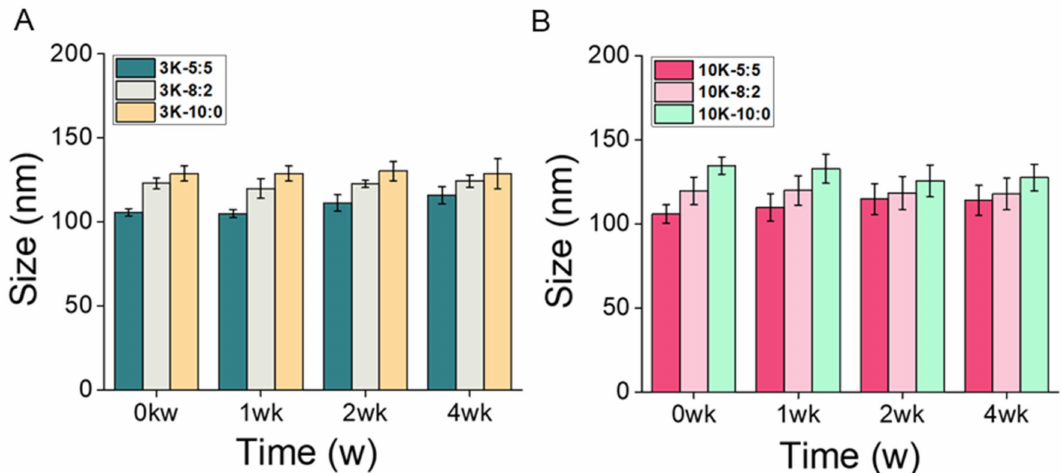
Figure 4. Stability analysis of ( A ) CNS3Ks and ( B ) CNS10Ks over four weeks of storage in phosphate-buffered saline at 37 ◦ C under shaking at 100